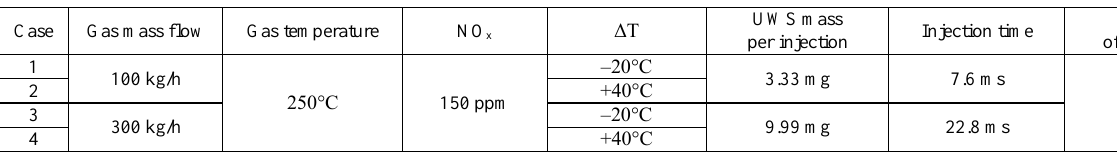
Table 1. Considered cases and corresponding physical conditions